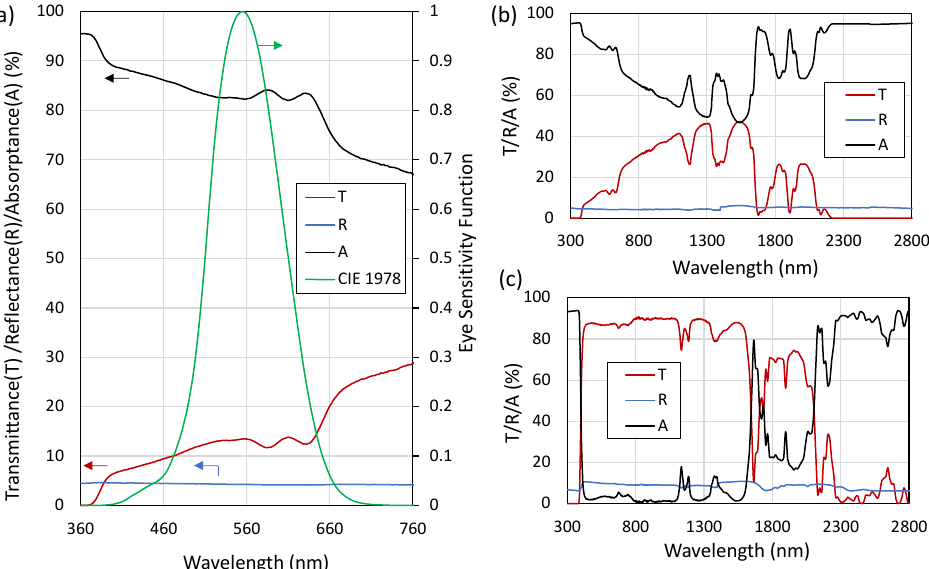
Figure 5. ( a ) The transmittance, reflectance and absorptance of the tinted acrylic sheet shown along with the CIE 1978 Eye Sensitivity Function. The transmittance, reflectance and absorptance of ( b ) the tinted acrylic sheet and ( c ) the clear acrylic sheet at the front of the Trombe wall prototype over the wavelength range from 300 nm to 2800 nm.